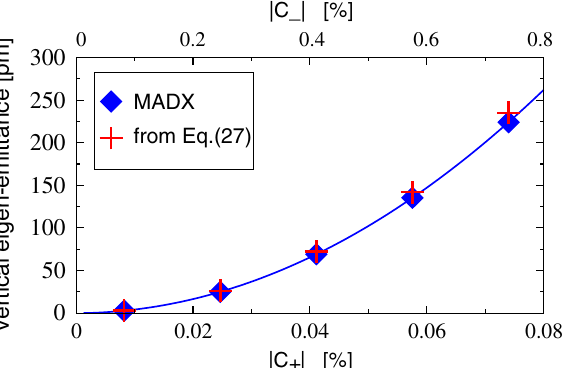
FIG. 13. Comparison between the vertical eigenemittance E computed by MADX (blue diamonds) and via Eqs. (26) and (27) (red plus) of Table